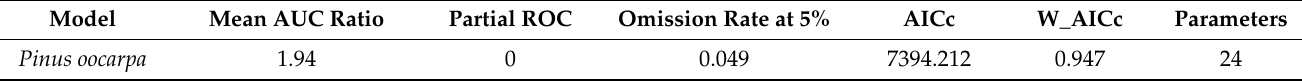
Table 7. Performance statistics for the best models